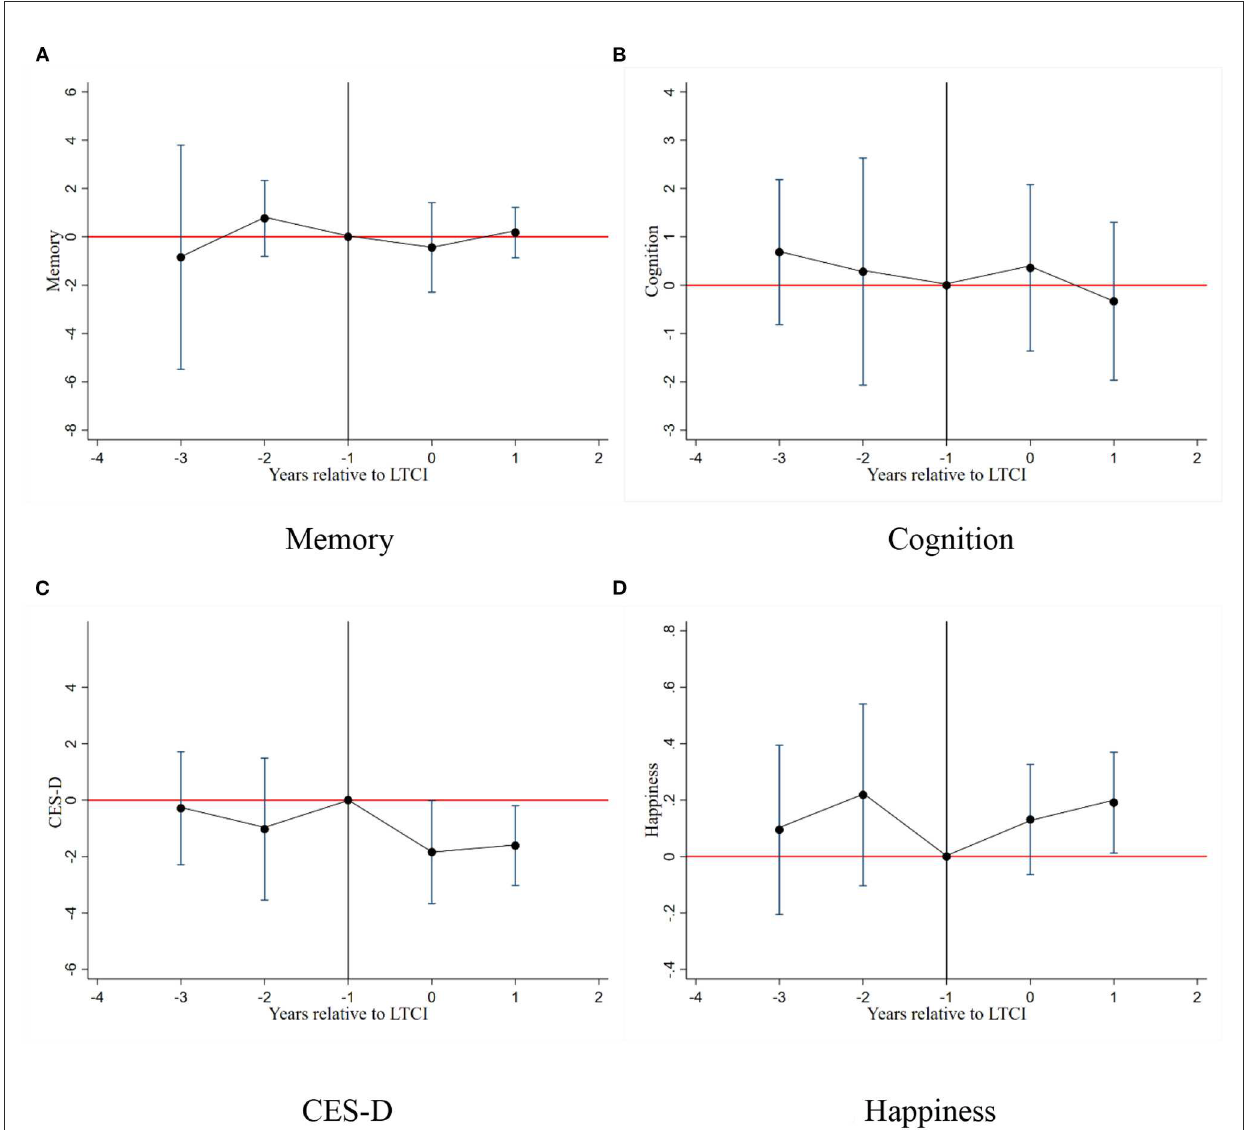
FIGURE2 Event study for the impact on the mental health. (A) Memory. (B) Cognition. (C) CES-D. (D) Happiness.